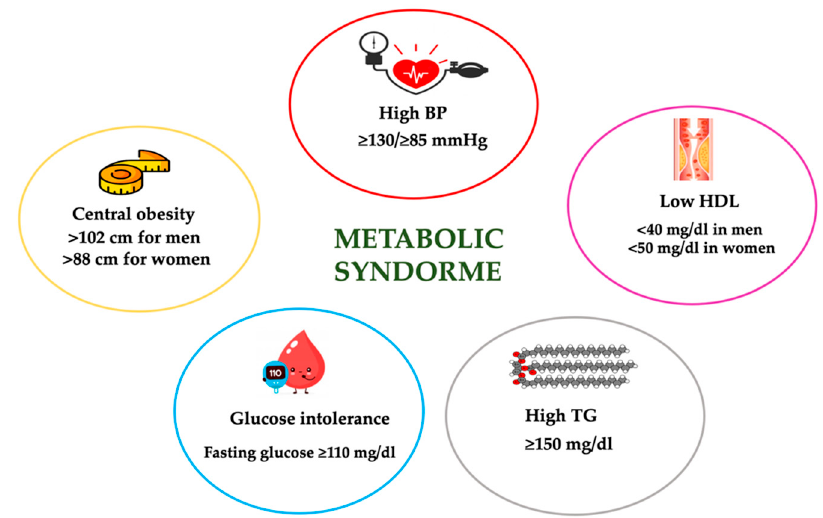
Figure 5. Definition of metabolic syndrome according to Adult Treatment Panel III National Cho- lesterol Education Program (ATP III-NCEP). BP, blood pressure; HDL-C, high-density lipoprotein- cholesterol; TG, triglycerides.